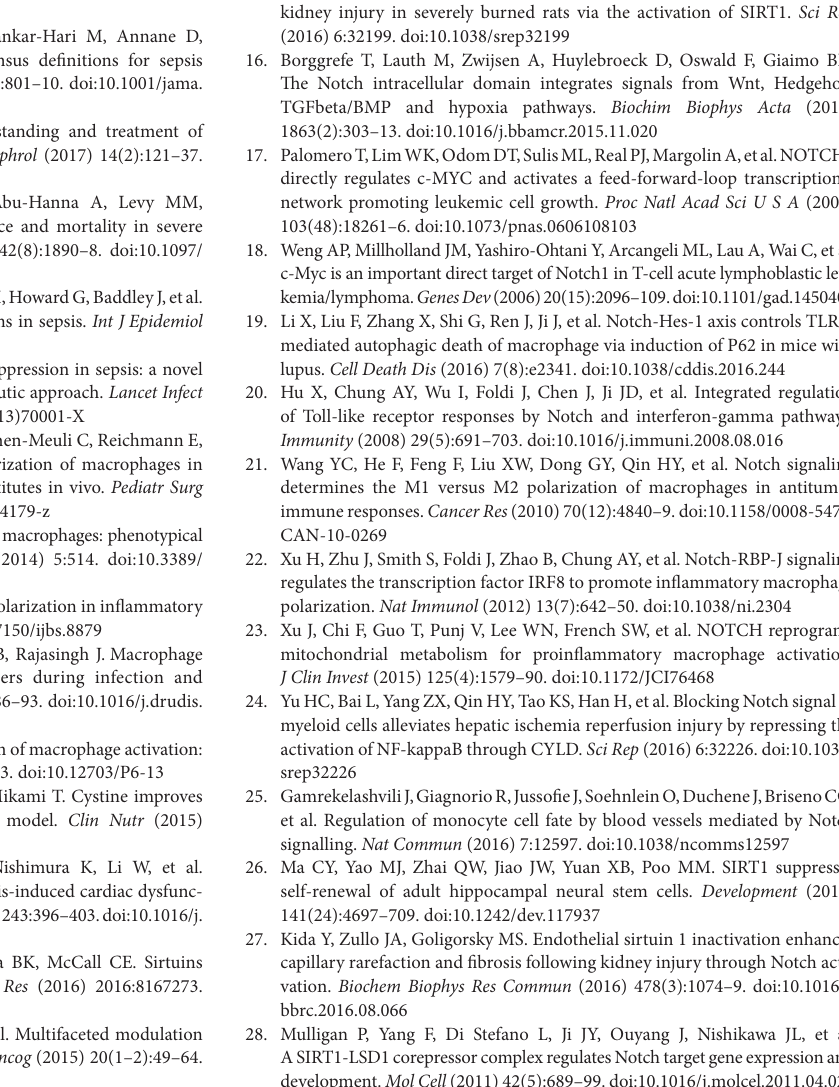
FigUre s2 | SRT1720 injection potently alleviated lipopolysaccharide (LPS)-induced organ injury in mice. (a) Hematoxylin and eosin staining of heart, liver, lung, and kidney tissues from SRT1720-injected and control (saline- injected) mice exposed to LPS; sections were examined and photographed under a microscope. (b) Blood from the left ventricle was collected and the levels of creatinine (Cr), blood urea nitrogen (BUN), alanine aminotransferase (ALT), and aspartate transaminase (AST) were assessed using commercial ELISA kits. ** p < 0.01 compared with LPS-treated control mice; n = 6. Scale bar = 50 µm. FigUre s3 | DAPT treatment lowered the levels of pro-inflammatory cytokines in lipopolysaccharide (LPS)-stimulated macrophages. Peritoneal macrophages collected from C57BL/6 mice were exposed to PBS (control), DAPT, LPS, or LPS + DAPT, and then the mRNA levels of IL-1 β , IL-6, TNF- α , and Hes1 were determined using RT-PCR. ** p < 0.01 compared with the LPS group; n = 6. FigUre s4 | Quantification of the results in Figure 6F , showing higher intracellular domain of Notch acetylation after transfection of H363Y SIRT1 plasmid than wild-type SIRT1 plasmid. Data were analyzed using Graph Pad Prism 5.01 software. **p <